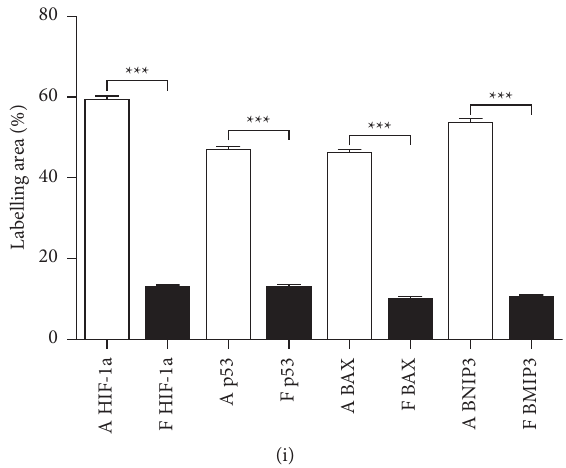
Figure 1: Immunomarking for HIF-1 α , p53, Bax, and BNIP3 in AMB and FP. HIF-1 α staining in AMB (a) was nuclear in the solid tumour area (arrowheads) and cytoplasmic and nuclear in cells near the cystic areas of the epithelial islets (arrow and cystic lumen, ∗ ). p53 immunostaining in AMB (c) is predominant in the nucleus and cytoplasm of cells close to the cystic areas (cystic lumen, ∗ ) of epithelial islands (arrow). Staining is also detected in selected cells from the basal layer (c) (arrowhead). Bax immunostaining in AMB (e) is predominant in the cytoplasm of cells close to the cystic areas of epithelial islands (arrow). BNIP3 immunostaining in AMB (g) is predominant in the cytoplasm of cells close to the cystic areas of epithelial islands. Marking is also detected in selected cells from the basal and central layers (arrowhead and arrow, resp.). The FP shows a weaker labelling of the HIF-1 α , p53, Bax, and BNIP3 proteins compared with AMB (b, d, f, h). Scale 100 and 20 μ m. Comparison of immunoexpression of the p53, Bax, and BNIP3) and HIF-1 α in the ame- loblastoma (a) and the follicle dental (f). ∗∗∗ p < 0 . 001